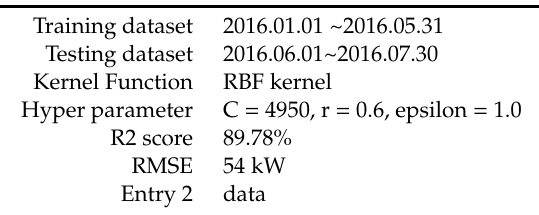
Table 3. Prediction result.